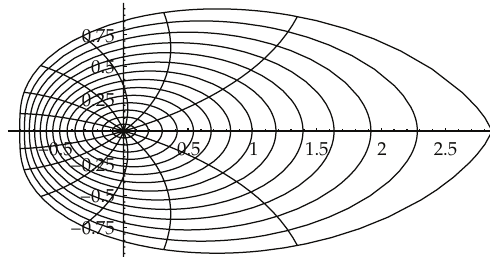
Figure 5: The image of f (cid:3) z (cid:4) in Example 3.5.